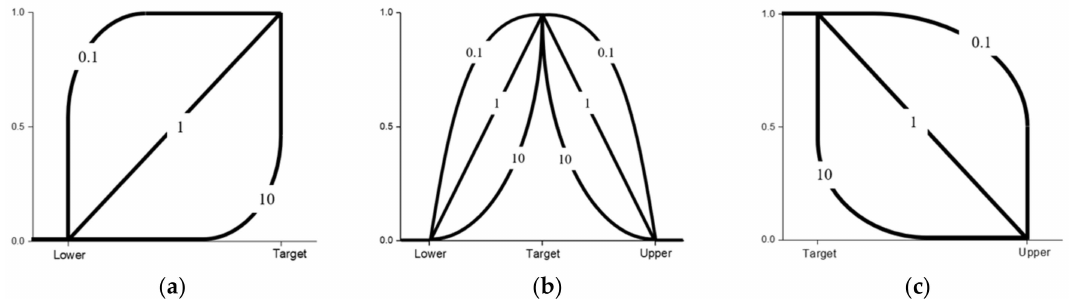
Figure 6. Desirability functions for different goals and how weights influence their respective shapes. ( a ) Minimize the response, ( b ) Achieve target value, and ( c ) Maximize the